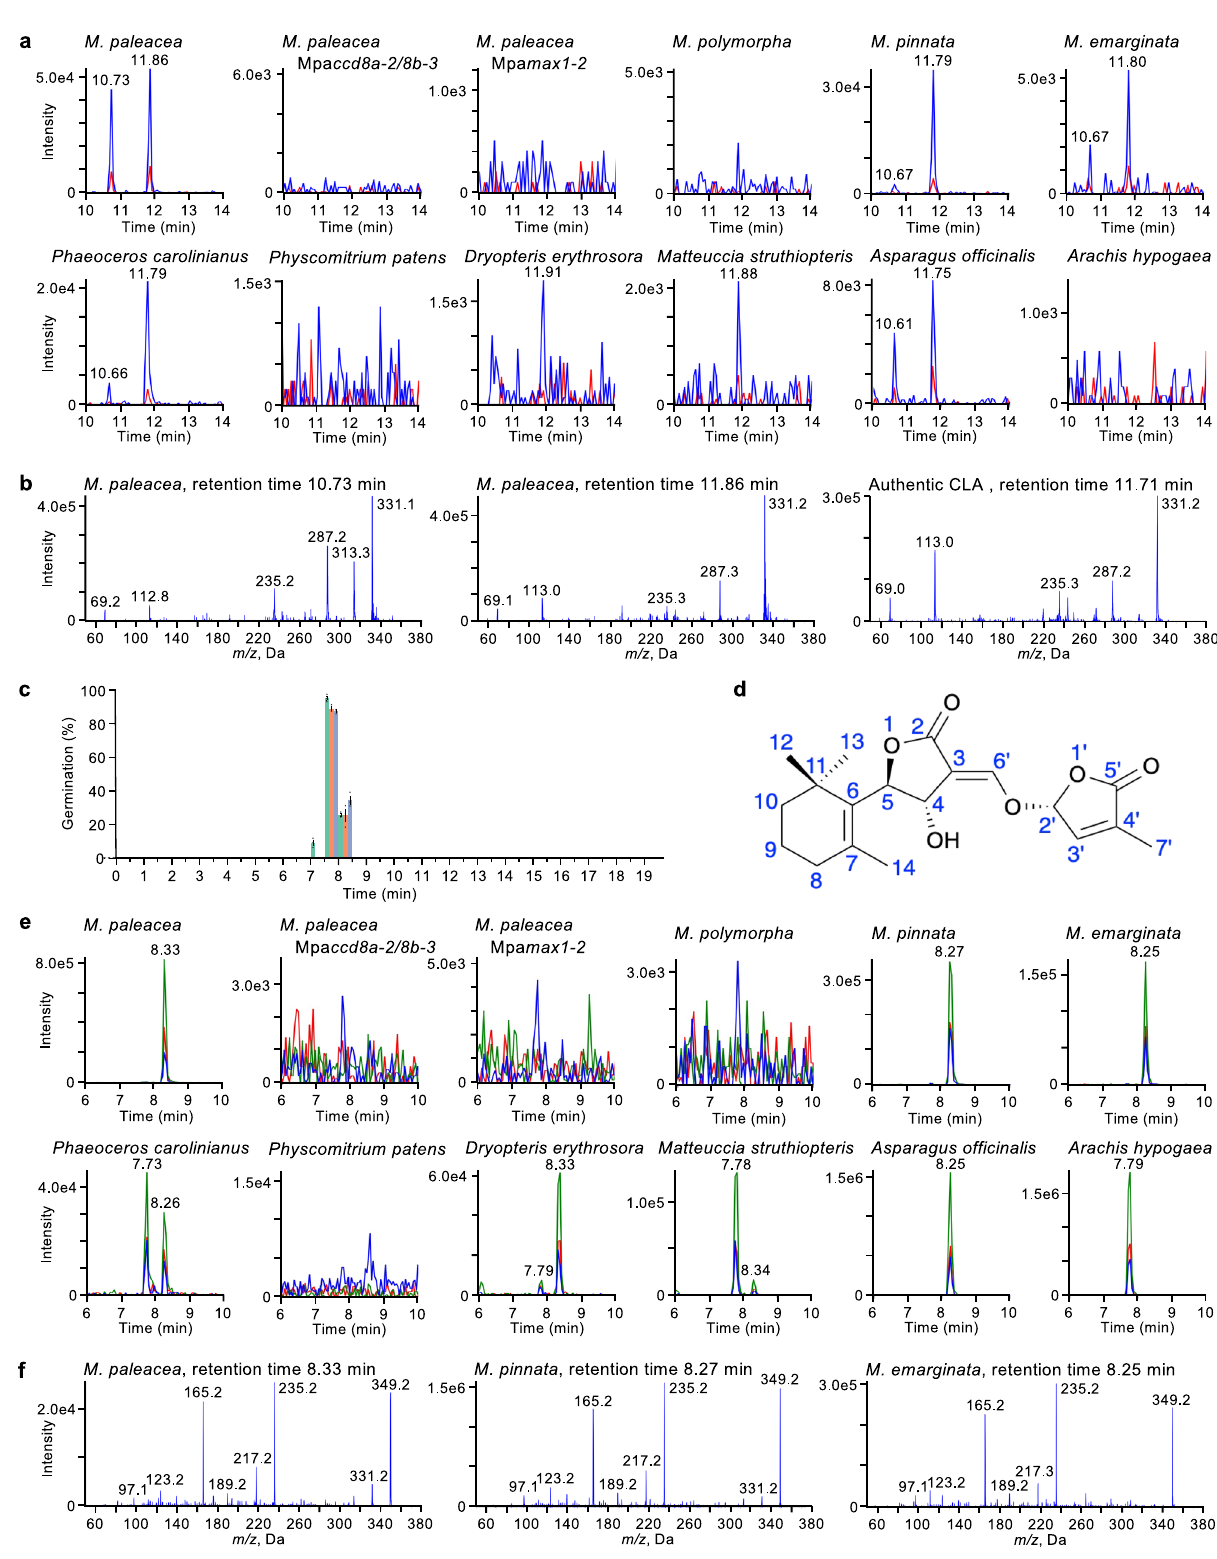
transcript level of the CCD8 gene in Anthoceros agrestis , a hornwort, was induced by phosphate starvation (Fig. 4a). To obtain a genome-wide view of the phosphate level- dependent gene expression in M. paleacea , we performed RNA- seq analysis (Fig. 4b). The expression of many genes changed under phosphate-de fi cient conditions (Supplementary Data